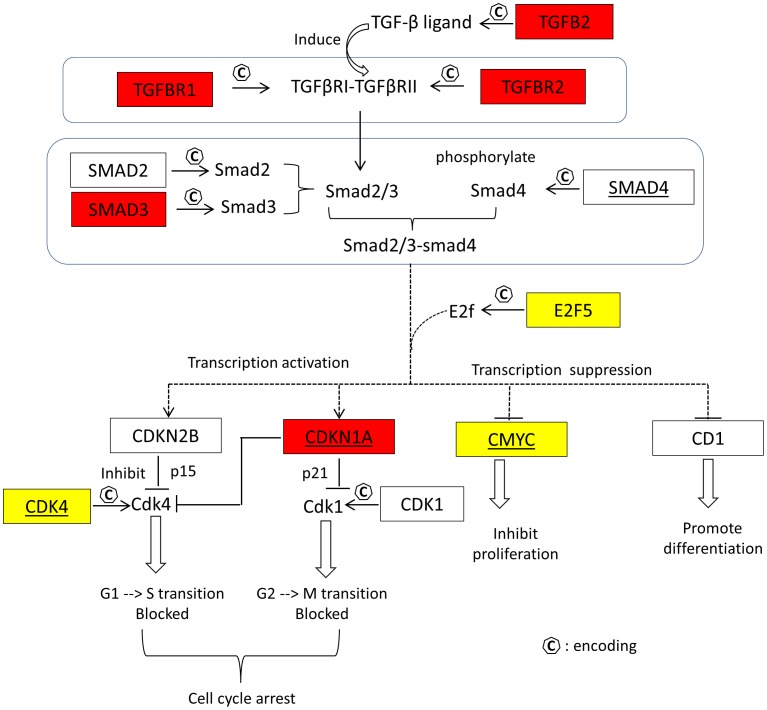
The interference of miRNAs in module p-module-5-ne in TGF-beta signaling pathway. The genes which have negative connections with the miRNAs in the modular network are shaded with red. Gene CDKN1A (albeit not in the module gene list) is also shaded with red because of the significant negative correlations (p<0.001) with hsa-miR-93, -106b and -200c at the expression level. Genes E2F5, MYC (CMYC) and CDK4, demonstrating an apparent pattern of positive transcriptional correlations with the modular miRNAs (
Figure 9
), are shaded with yellow.